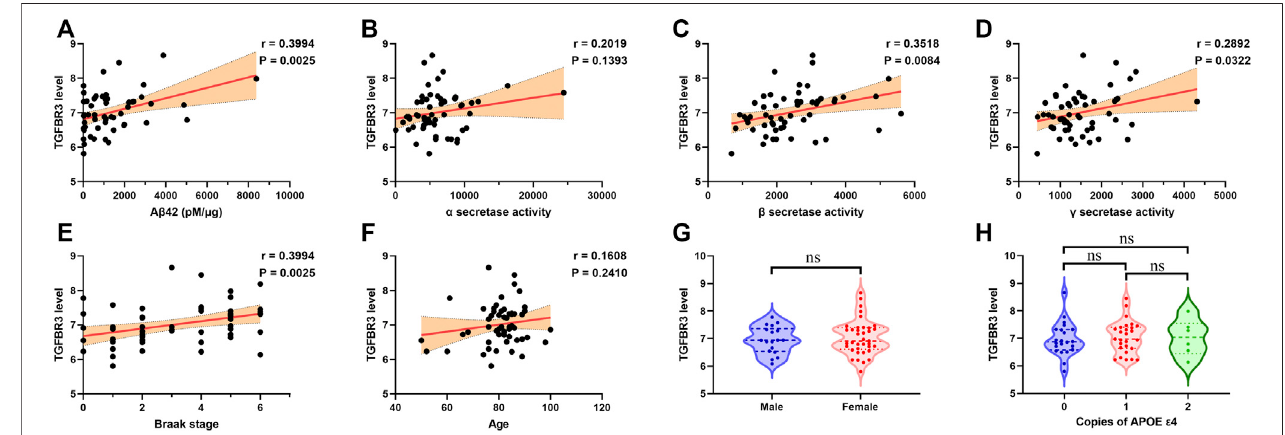
FIGURE 6 | TGFBR3 expression positively correlated with β - and γ -secretase activities (A-F) Pearson correlation analysis was used to evaluate the association between TGFBR3 level and A β 42 level (A) , α -secretase activity (B) , β -secretase activity (C) , γ -secretase activity (D) , Braak stage (E) and Age (F) in 55 brain temporal cortex tissues from the expression dataset 3 (G) TGFBR3 level in male and female (H) TGFBR3 level in different APOE genotypes. ns p > 0.05.